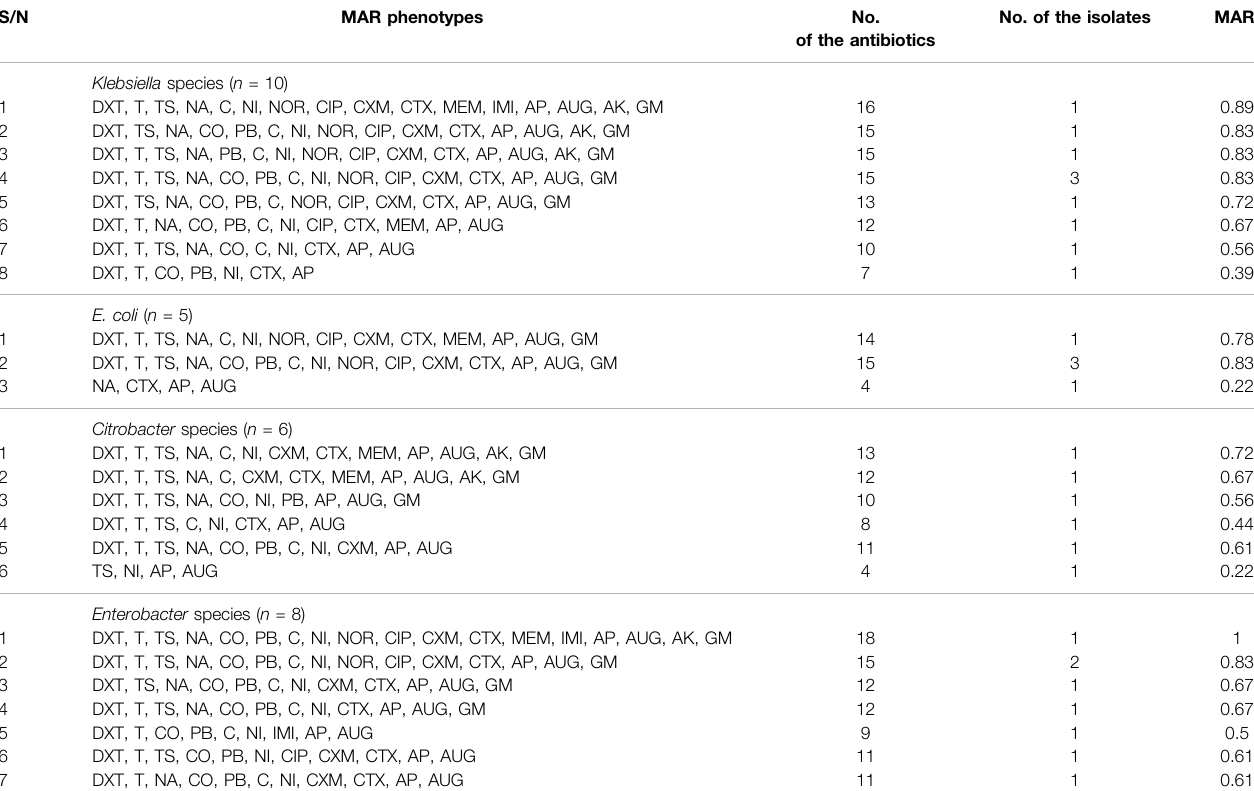
TABLE 1 | The patterns of the MARPs and MARI of Enterobacteriaceae from municipal WWTPs ’ ef fl uents. S/N MAR